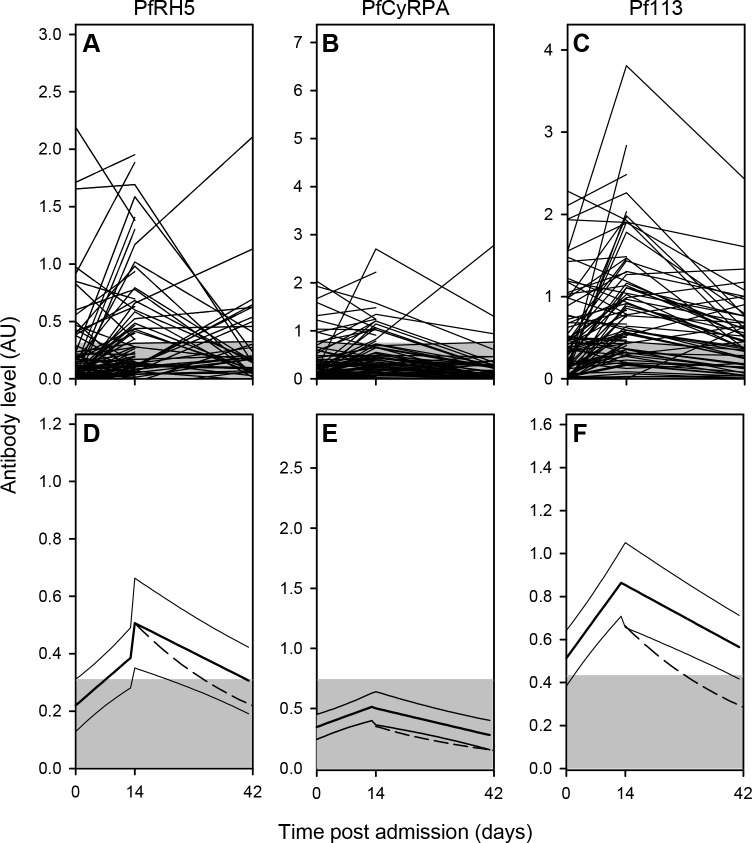
Kinetics of merozoite-specific IgG levels following episodes of P. falciparum malaria.Plasma levels of IgG specific for PfRH5 (A, D), CyRPA (B, E), and Pf113 (C, F) in children with P. falciparum malaria (Day 0), and in the same children two weeks (Day 14) and six weeks (Day 42) later. Temporal changes in levels of IgG in individual children (A-C) and in the cohort mean IgG level (D-F). Data from individual children are connected by lines (A-C). Cohort running means (heavy lines) and their 95% confidence intervals (thin lines), calculated as described previously [34], as well as calculated catabolic decay from Day 14 (dashed lines) are shown (D-F). Negative cut-offs (shaded areas) are shown (all panels). The presented data is from one experiment.